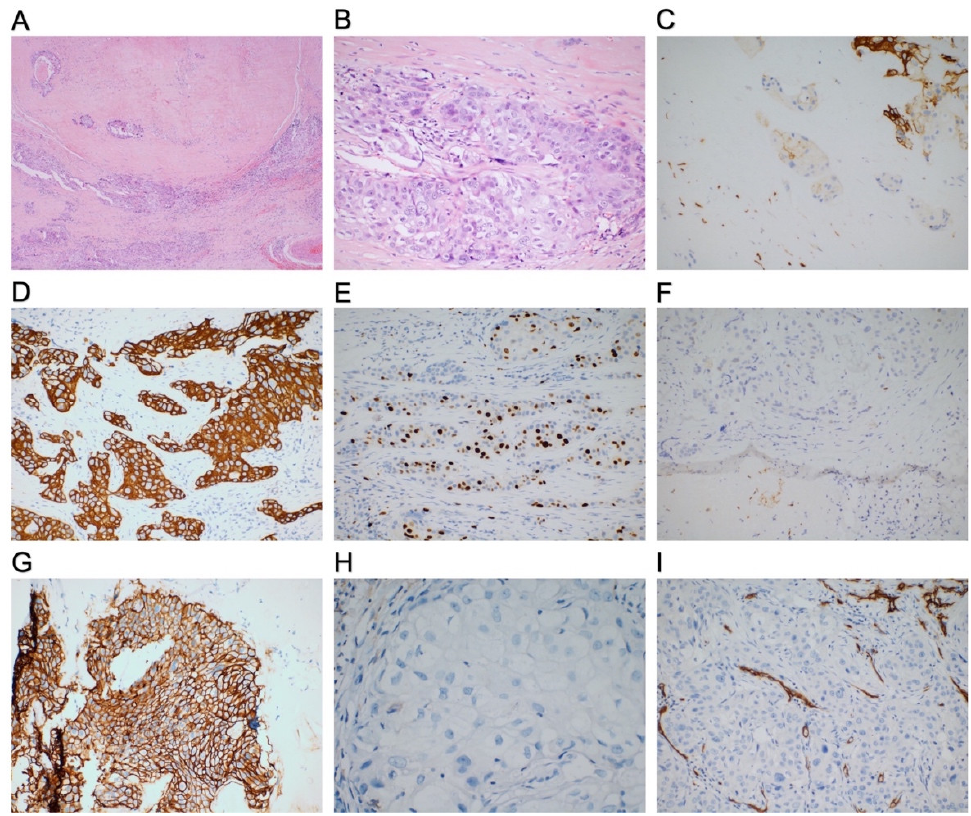
Figure 1. Histological examination of CA ex PA. ( A ) Low magnification showed a PA in the form of a nodule with a fibrous mucinous stroma, with some malignant epithelial components visible within the nodule and at the nodule margin (HE). ( B ) High-power view revealed a solid nest of malignant epithelial components and vesicular nuclei of tumor cells with large, hyperchromatic nuclei and conspicuous nucleoli (HE). ( C ) IHC showed that tumor cells are positive for CK5/6. ( D ) IHC showed that tumor cells are diffuse strong-positive for CK7. ( E ) IHC showed that Ki-67 was about 30%. ( F ) IHC showed that tumor cells were weakly-positive for P63, and the residual myoepithelial cells of peripheral PA were positive. ( G ) IHC showed that tumor cells are strongly positive for the human epidermal growth factor receptor 2 (HER2) (clone 4B5) overexpression. ( H ) IHC showed that tumor proportion score (TPS) for programmed cell death ligand 1 (PD-L1) was <1% (clone 22C3). ( I ) IHC showed that vascular endothelial cells of the stroma are positive for CD34. (A 40×, B–G, and I 200×, H 400× magnification).